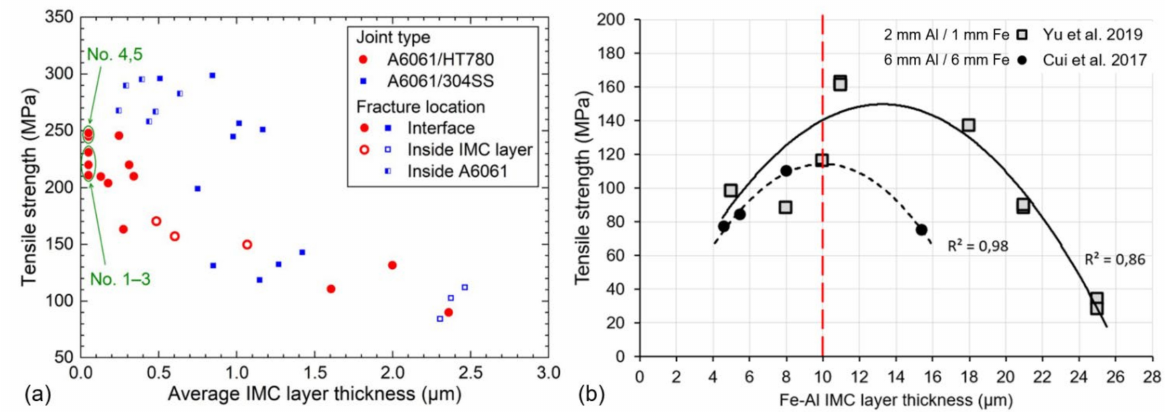
Figure 12. Effect of Fe–Al IMC layer thickness on tensile strength: ( a ) in FSW [105] of 1 mm thin plates in butt joint configuration; ( b ) in arc-assisted laser welding in butt joint for different sheet thicknesses